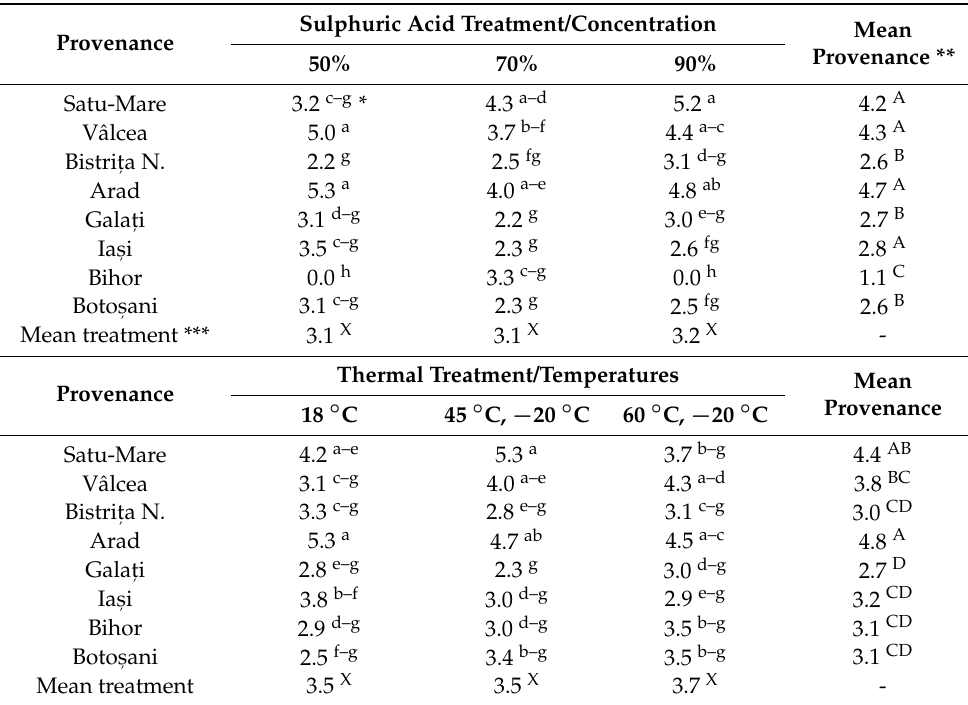
Figure 3. Black locust seed germination (%) evolution in days, depending on the treatments applied with three concentrations of sulphuric acid. Table 5. Seedling diameter (cm) depending on the treatments applied to black locust